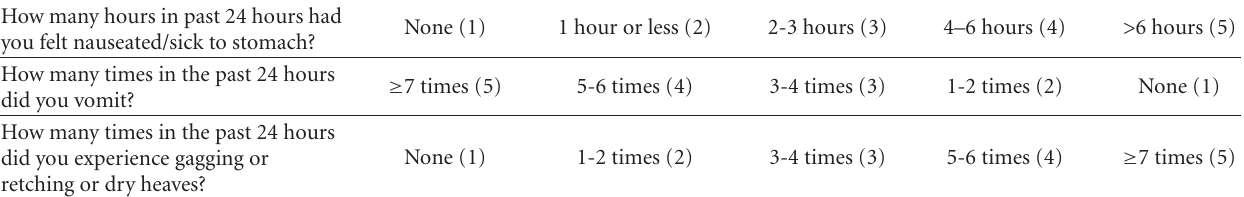
Table 1: Motherisk-pregnancy-unique quantification of emesis and nausea (PUQE) scoring system. The PUQE scale is a validated scoring system to quantify the severity of NVP based on quantification of the 3 physical symptoms of NVP (nausea, vomiting, and retching)